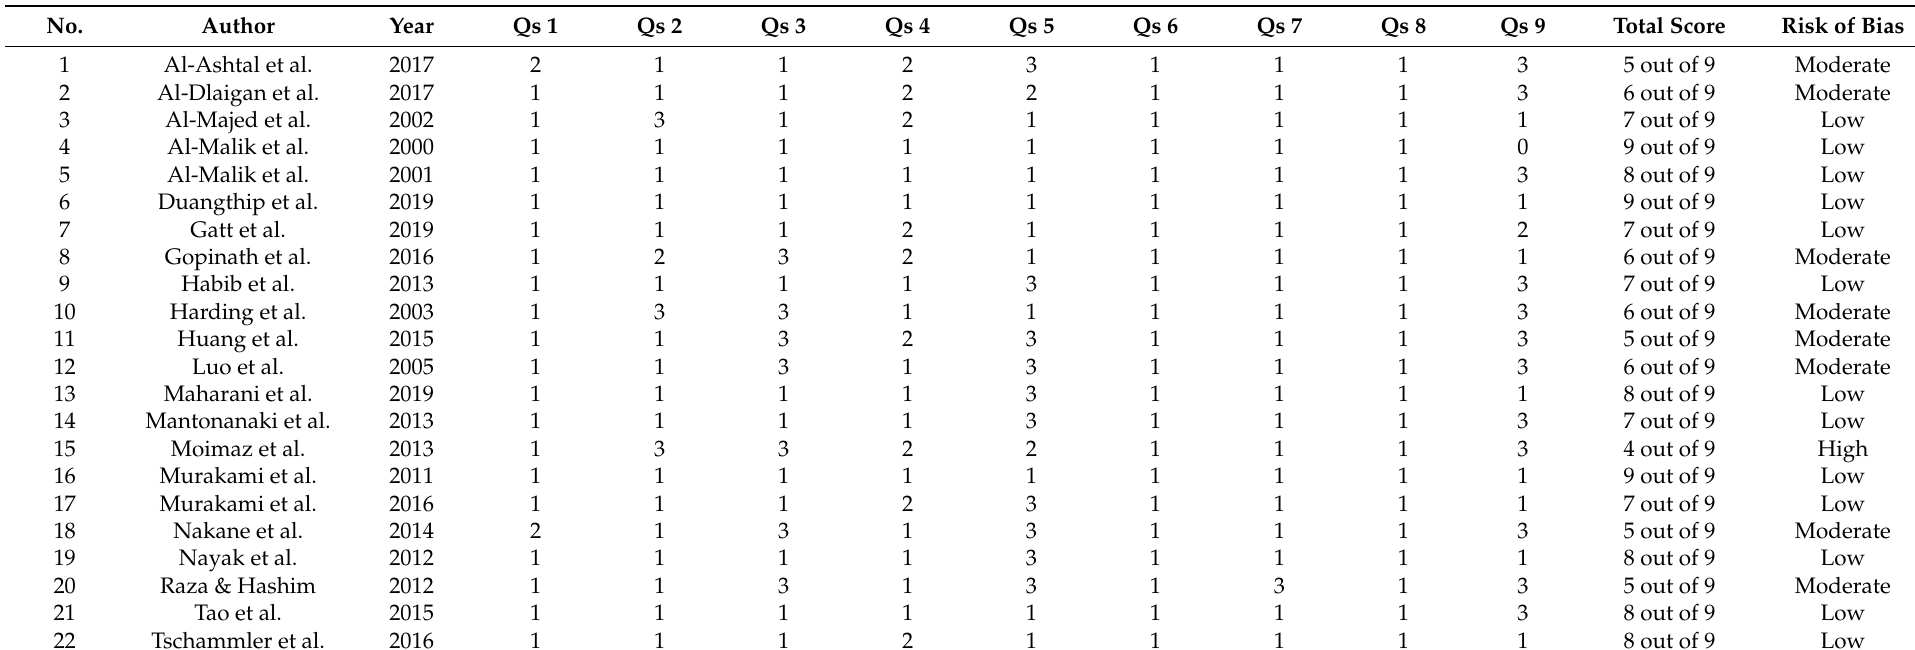
Table 2. Risk of bias of included